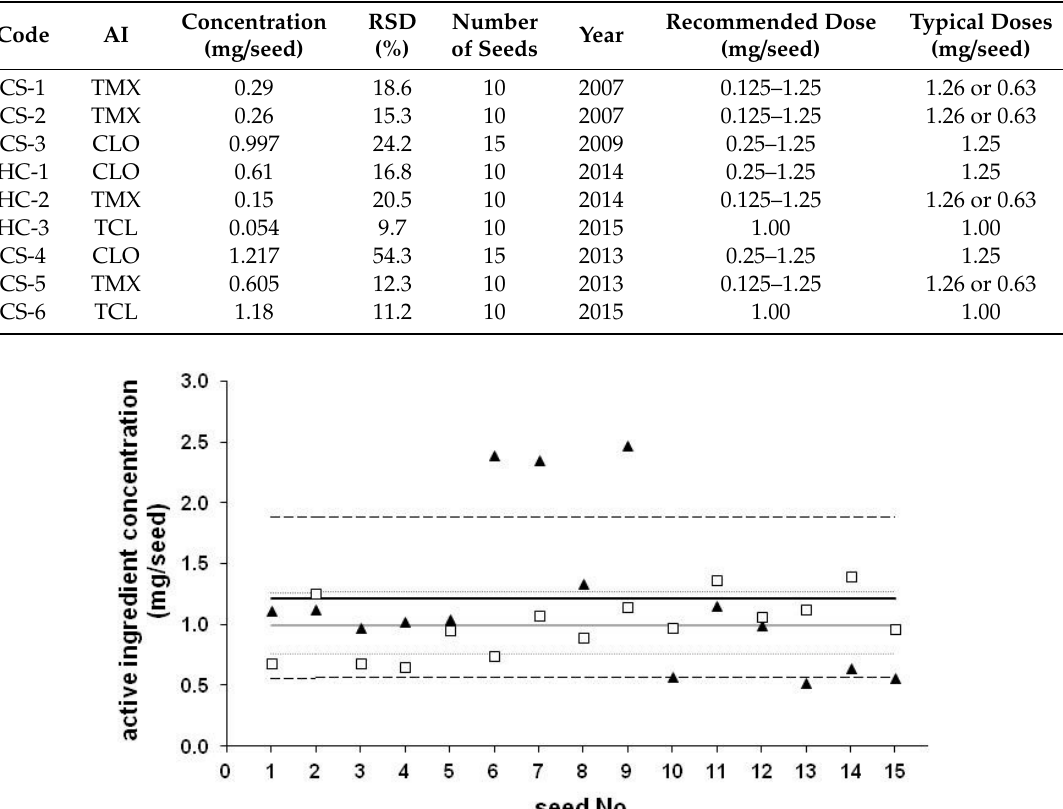
Figure 1. Concentration of clothianidin (CLO) on individual seeds (mg / seed), CS-3 (square) and CS-4 (triangle). Average concentration determined for 15 seeds (continuous lines) and the relative standard deviation (RSD) (dashed lines).